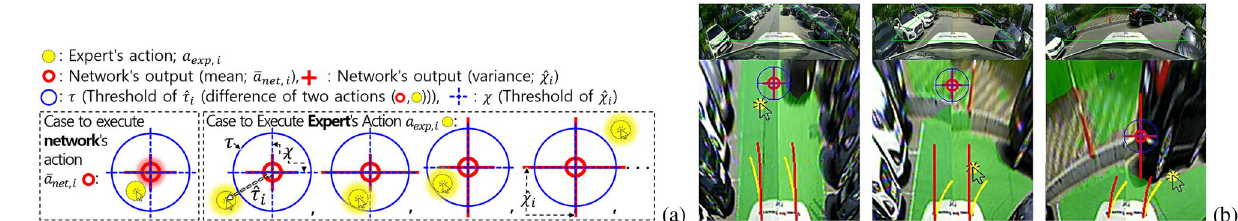
Figure 4. Illustration of the data-sampling function of WeightDAgger : ( a ) Whether executing the network’s action ( ¯ a net , t ) or the expert’s action ( a exp , t ). ( b ) Unsafe or near-collision situations and collecting the additional dataset. In this example, DAgger is in iteration i = 1, and the network π net , i = 1 has the behavior cloning policy, π BC . The yellow point is the newly labeled action a exp , t of the expert while π BC is being executed. The red point in the combined image x t is the mean of the output by π net , i : the network’s action ¯ a net , t . The blue circle is the threshold τ of ˆ τ t which is the difference between the actions ¯ a net , t and a exp , t . The red lines centered at ¯ a net , t represent the variance of the output of π net , i : ˆ χ t . The blue dashed lines centered at ¯ a net , t represent the threshold of ˆ χ t which is the variance of the output of the network π net , i : χ